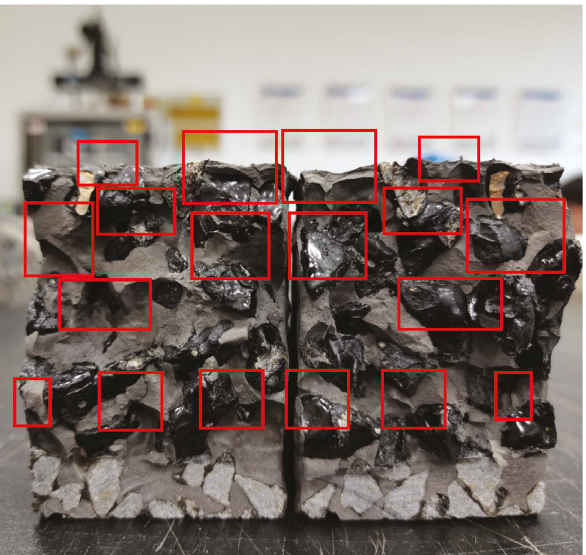
Figure 18: Fracture surface of